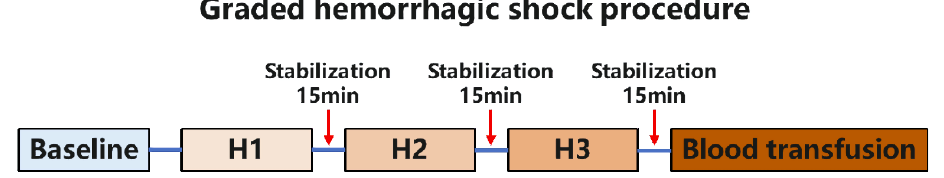
Figure 1. Graded hemorrhagic shock and resuscitation protocol. BL: baseline; H1: the first stage of hemorrhage with 5 mL/kg of blood accumulated; H2: the second stage of hemorrhage with 10 mL/kg of blood accumulated; H3: the third stage of hemorrhage with 20 mL/kg of blood accumulated; T: the last stage of transfusion of autologous blood.